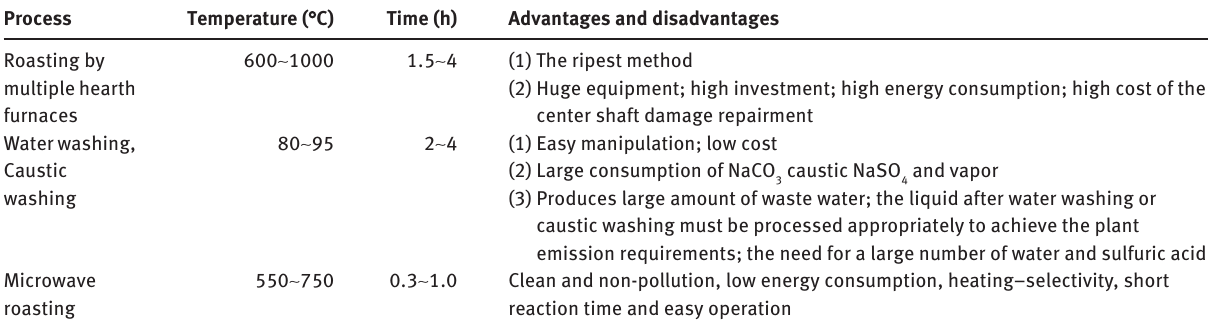
Table 4: The control conditions and comparisons of several dechlorination processes.